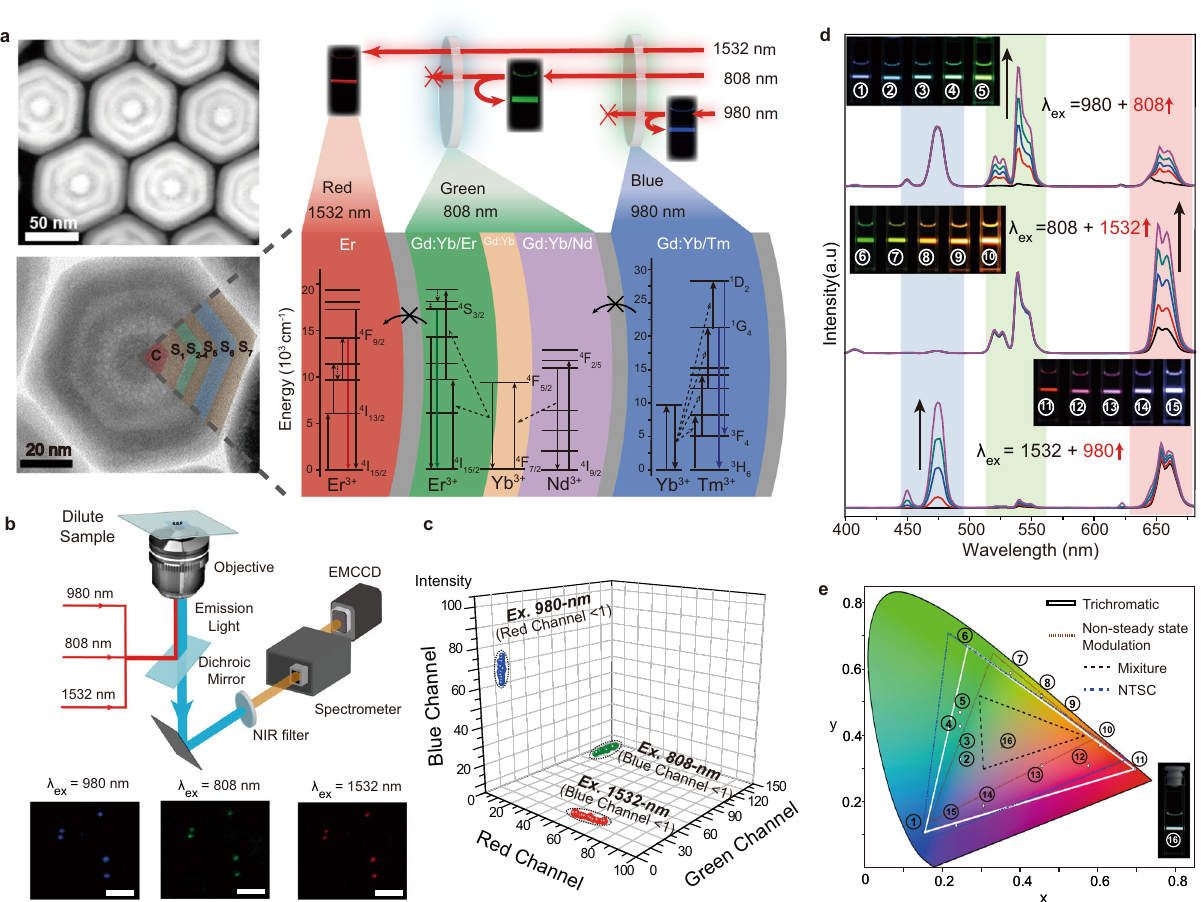
Fig. 2 Optical property of trichromatic UCNPs. a The high-angle annular dark fi eld scanning transmission electron microscopy image (top-left) and high- resolution transmission electron microscopy (TEM) image (bottom-left) of the obtained multilayer UCNPs and the corresponding schematic illustration of energy dissipation upconversion process in multilayer UCNPs. The synthesis was repeated four times with similar results. b Spectrograph-coupled optical microscopy setup for single-particle imaging and in situ spectral analysis and upconversion luminescent images of individual UCNPs spots under 808, 1532, and 980 nm excitation. Scale bar, 3 μ m. The imaging test was repeated by twice with individual samples. c Scattering plots of RGB channel intensity of single-particle luminescent spots under different excitations. Images and corresponding spectra were collected under ~120 mW/mm 2 excitation with 60 s exposure time. RGB channel intensity was calculated from average intensity within a speci fi c wavelength range (438 – 480 nm for blue, 507 – 560 nm for green, 640 – 700 nm for red). d Upconversion luminescence spectra and corresponding photographs of trichromatic UCNPs under dynamic tuning of dual- excitation laser power. e Color gamut of the tuning emissions point (1) to (16) in d (marked with the white triangle), nonsteady state modulation (marked with the brown dotted triangle), and the National Television Standards Committee (NTSC) standard (marked with the black dotted triangle). Insert: white color at point (16) under co-irradiation of three lasers. The corresponding color space area reported in this work cover 84% of NTSC. Source data are provided as a Source Data fi